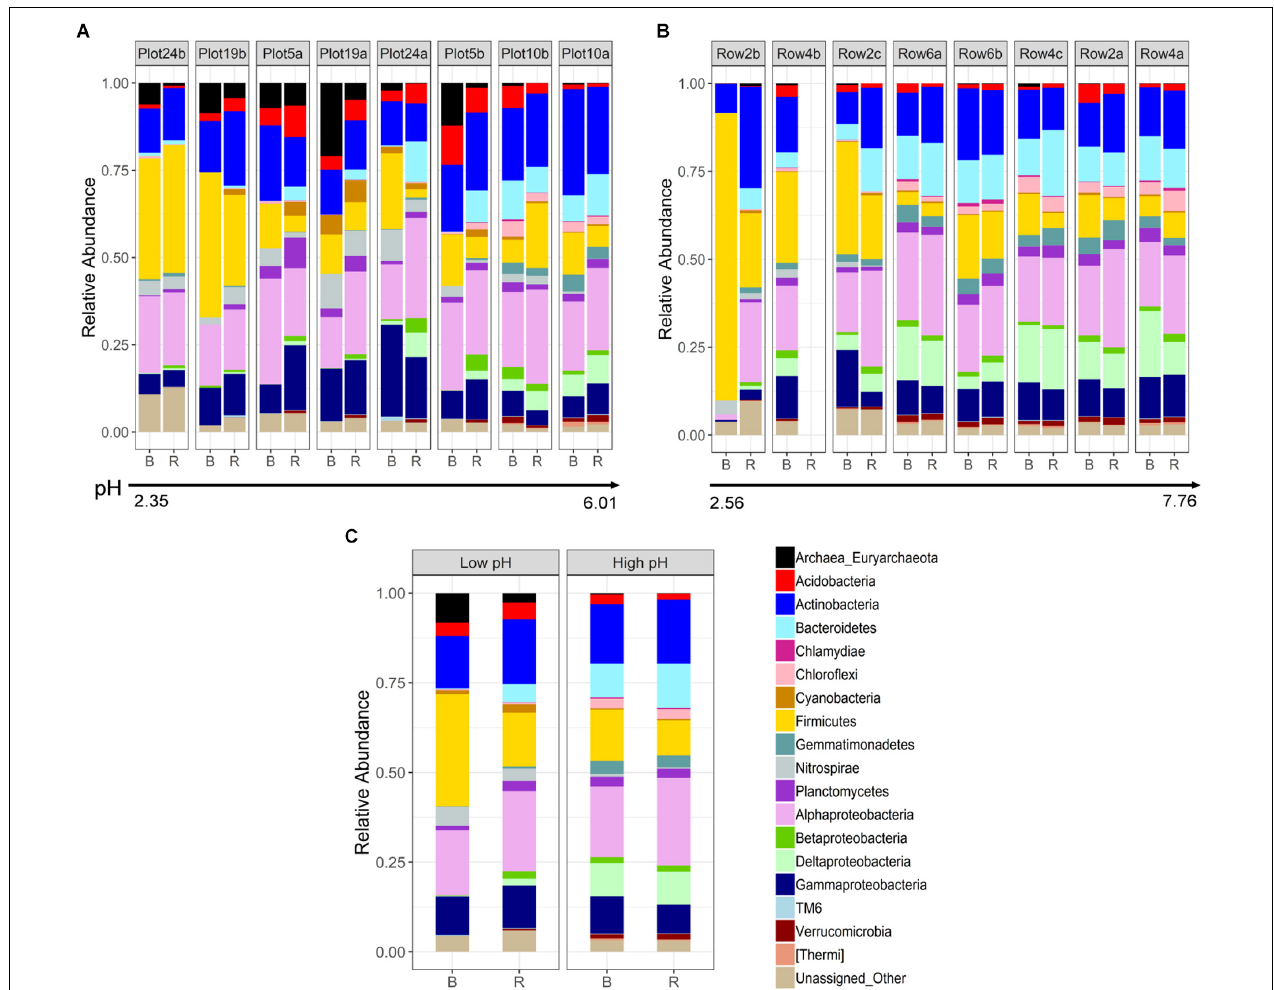
FIGURE 2 | Phylogenetic profiles of (A) Phase 1 and (B) Phase 3 rhizosphere and bulk samples collected from buffalo grass plants used to phytostabilize pyritic metalliferous mine tailings, in order of increasing pH. For explanation regarding missing data (Row4b.R), please see Methods section. (C) Averaged phylogenetic profiles across low pH ( < 4) and high pH ( > 4) rhizosphere and bulk samples. B, bulk; R,